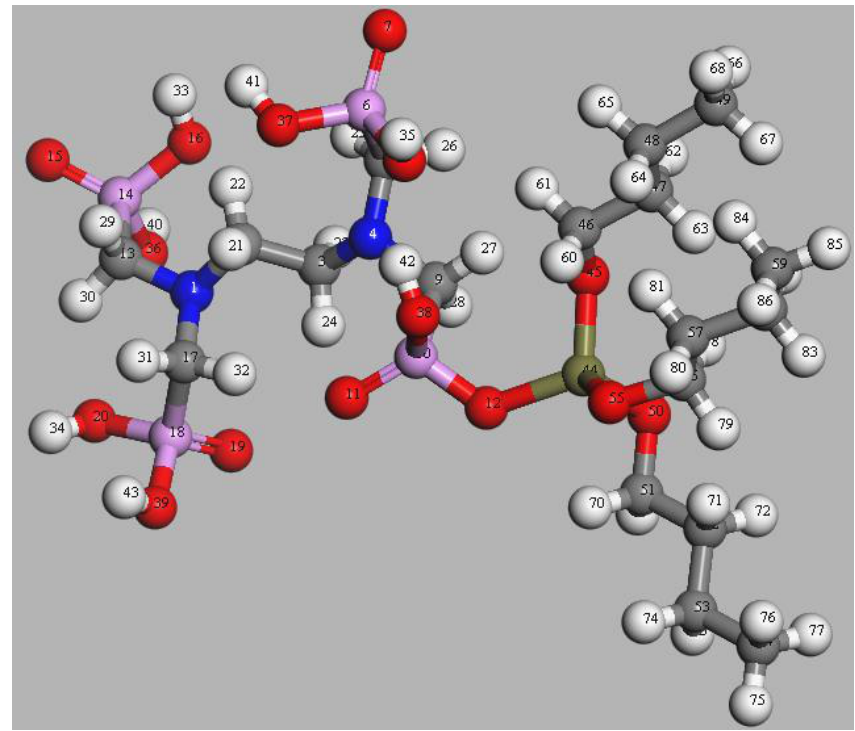
Figure 5. Optimized structure of EDTMPA-TBOT ligand with the numbered atoms: numbered atoms are denoted as follows: 21–35, 40–43, 60–86, hydrogen; 2, 3, 5, 9, 13, 17, 46–49, 56–59, 51–54, carbon; 7, 8, 11, 12, 15, 16, 19, 20, 36–39, 45, 50, 55, oxygen; 1, 4, nitrogen; 6, 10, 14, 18, phosphorus; 44, titanium.